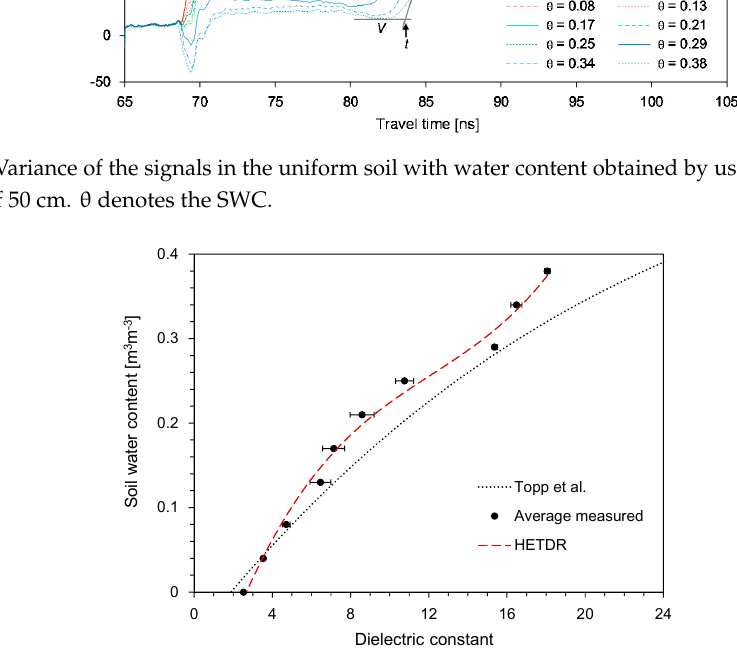
were greater than those for lower SWC, the third degree polynomial relationships established for all probes had coefficients of determination >0.994.